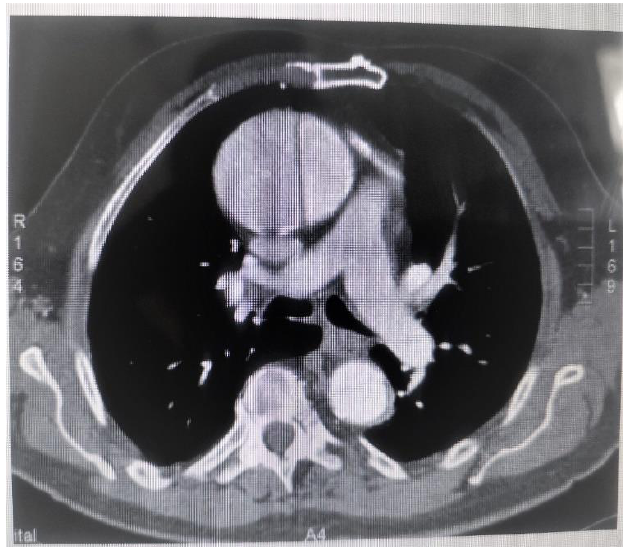
Fig. 4. Computed tomography shows a dilation and aortic